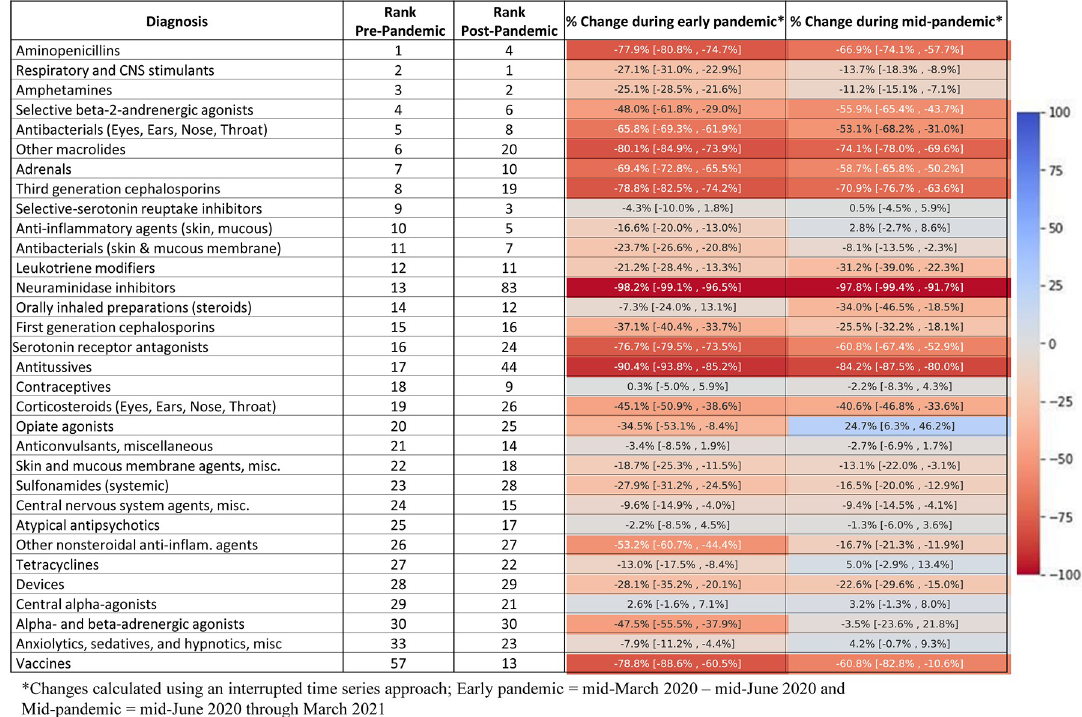
Fig 4. Pandemic changes in leading prescriptions with heat